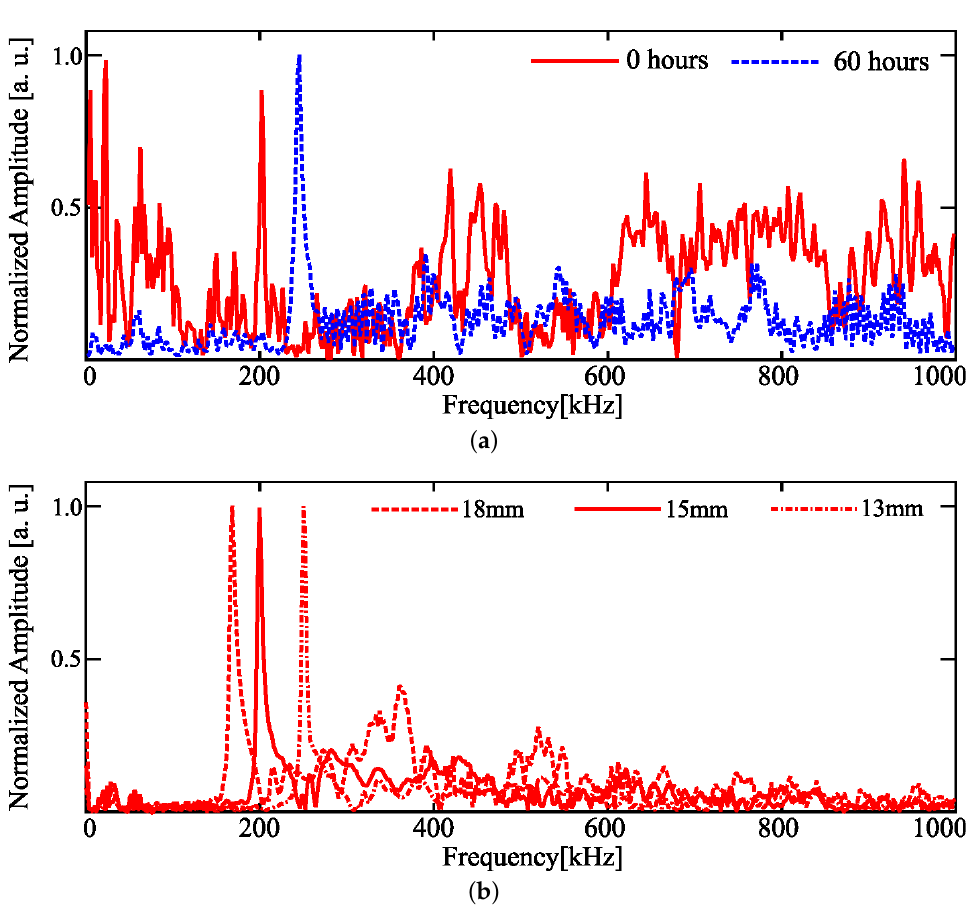
Figure 11. Comparison of the location of the sharp peak in the frequency domain; ( a ) is the enlarged frequency spectrum of 0 and 60 h from Figure 8 and ( b ) is the frequency spectrum of the naked steel rod with varying